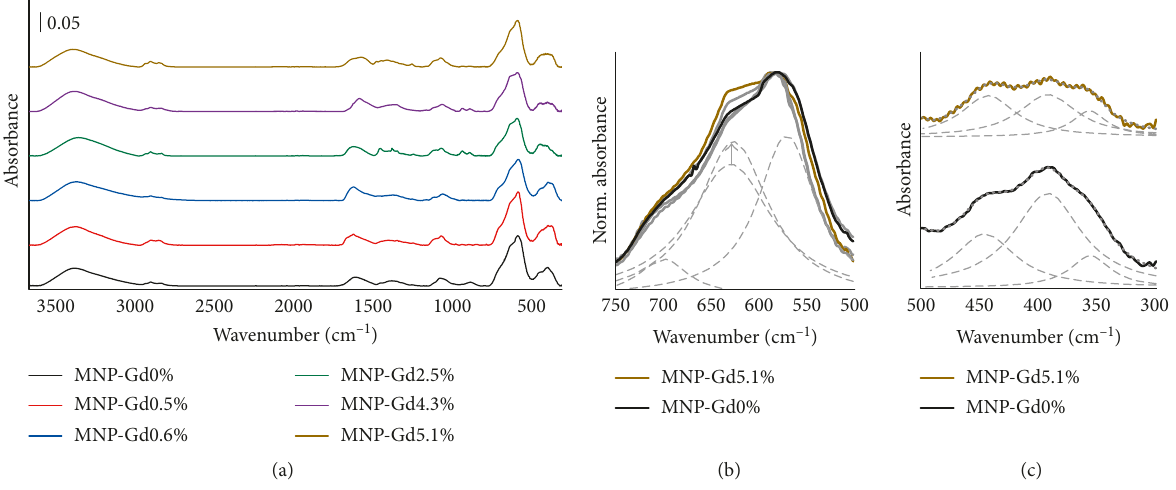
Figure 4: (a) FTIR spectra of synthesized samples: (1) MNP-Gd0%; (2) MNP-Gd0.5%; (3) MNP-Gd0.6%; (4) MNP-Gd2.5%; (5) MNPGd4.3%; (6) MNP-Gd5.1%. (b) An enlargement of the 500–750 cm 1 of normalized intensity together with fitting results for the MNP-Gd0% sample. (c) An enlargement of 300–500 cm ∼ 600 cm interval reporting the absorption band centered at ∼ 400 cm −